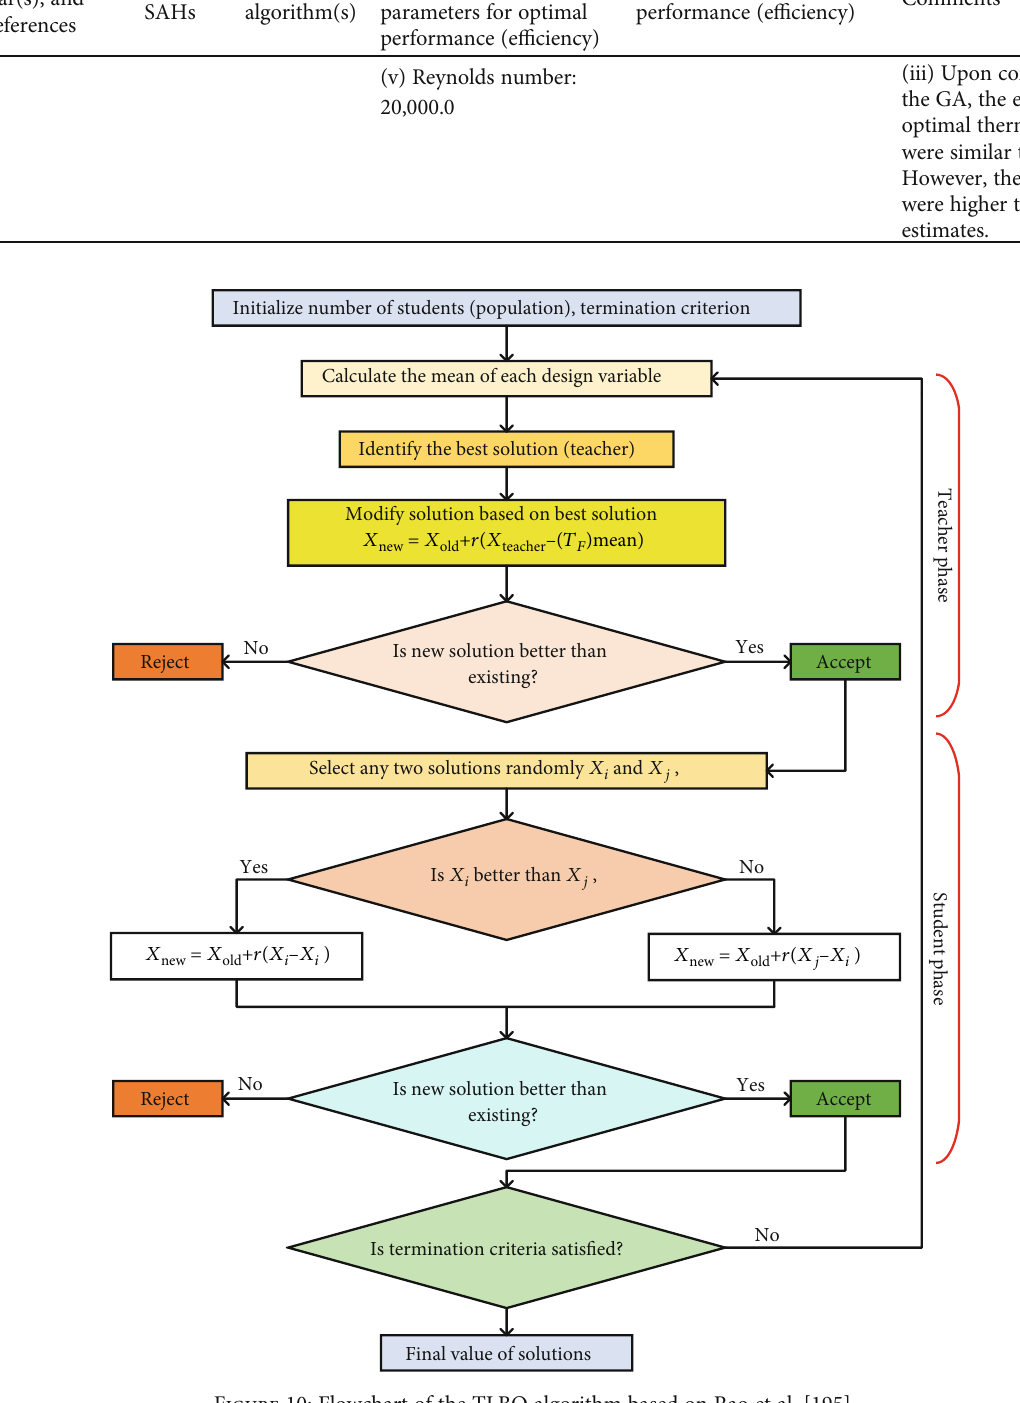
Figure 10: Flowchart of the TLBO algorithm based on Rao et al.